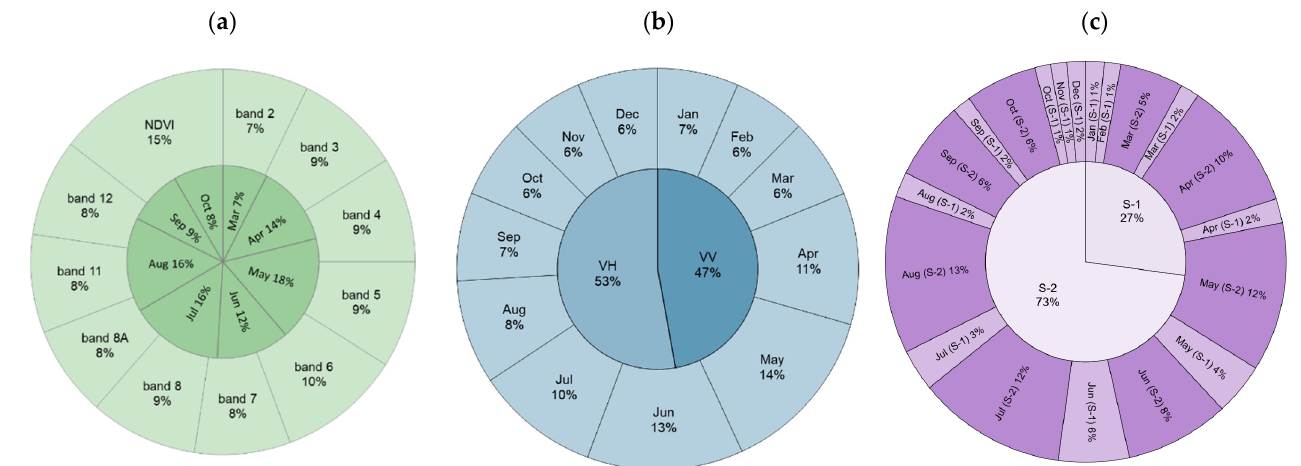
Figure 3. Sums of feature importance scores for groups of features ( a ) showing the importance of temporal intervals and bands/indices of the model runs with only Sentinel-2 data (S2), ( b ) showing the importance of intervals and polarization of the model runs with only Sentinel-1 data (S1), and ( c ) showing the importance of the intervals and sensor type features in the combined S12 model.